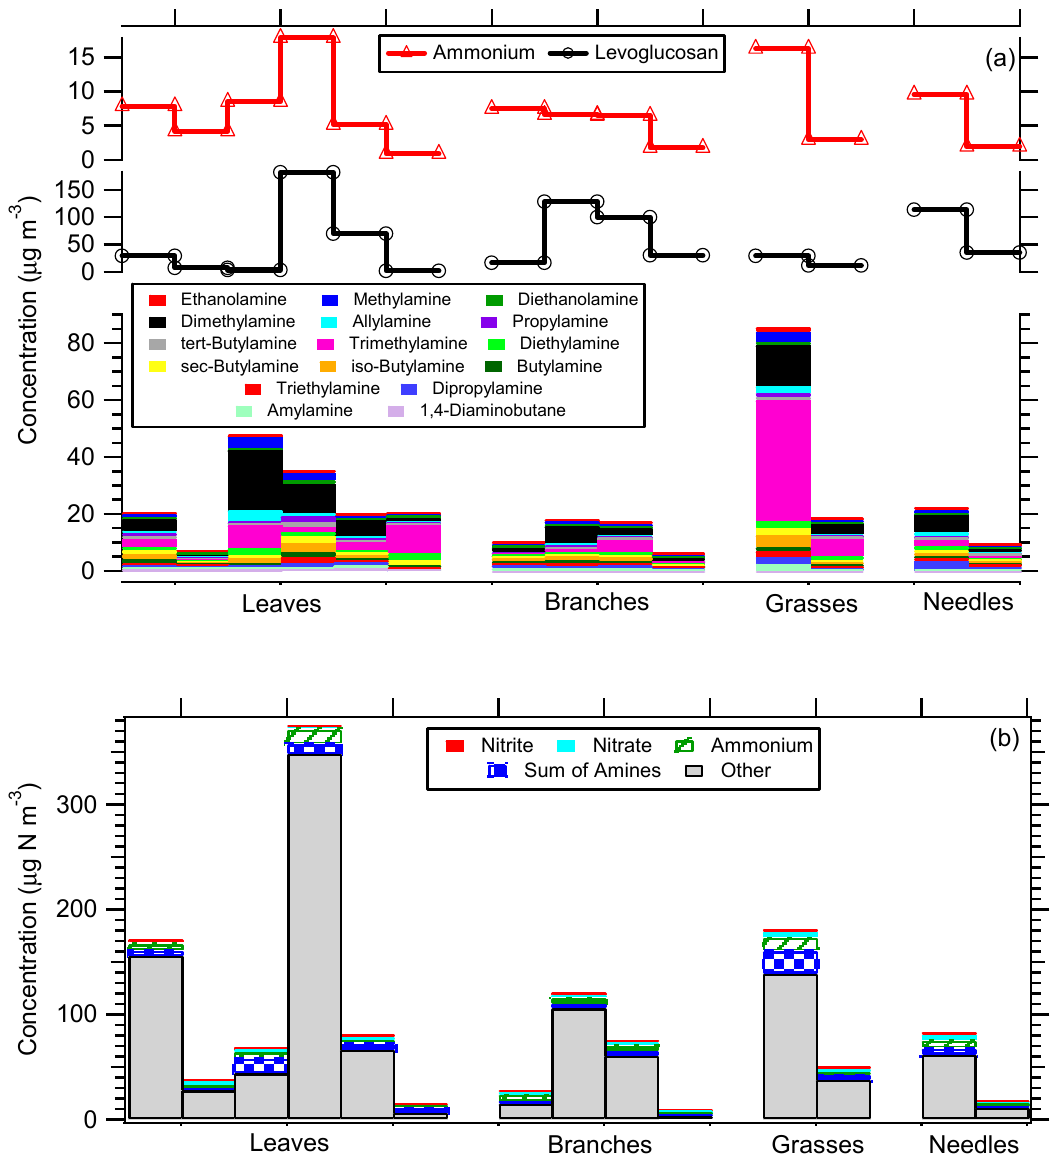
Figure 7. ( a ) Contribution of ammonium, levoglucosan, and the various particle-phase amines, and ( b ) nitrogen containing species to the total nitrogen from filter samples collected during controlled